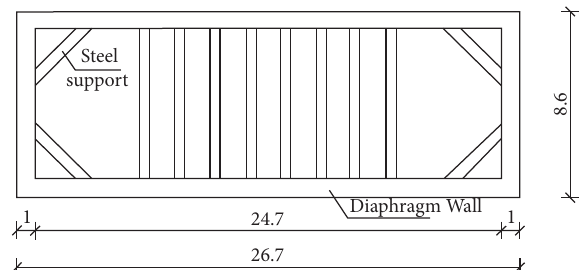
Figure 5: Geological section and cross section of steel support (unit: